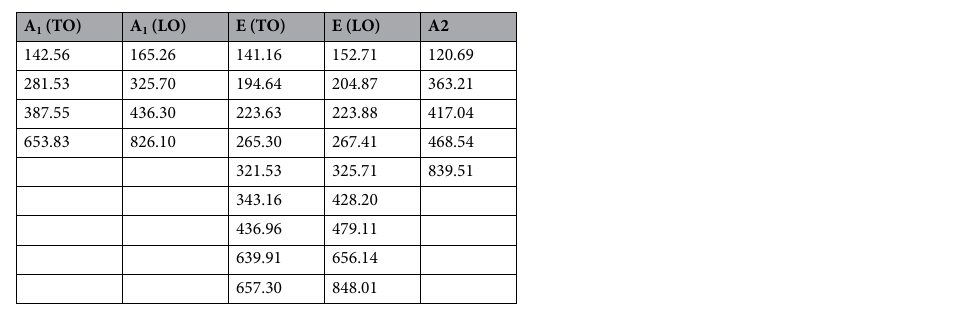
Table 5. The frequencies (cm − 1 ) of transverse optical (TO) and longitudinal optical (LO) zone-center optical phonon modes of the LiNbO 3 -type ZnTiO 3